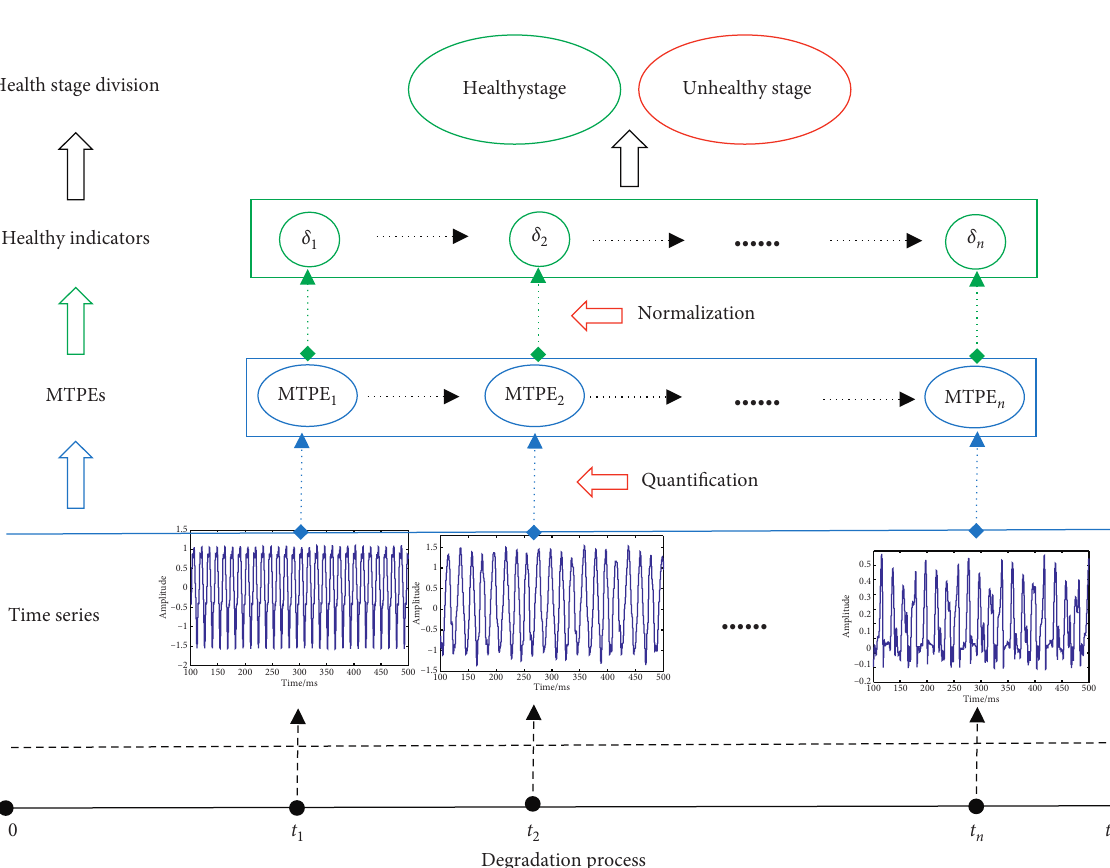
Figure 6: Procedures for performance degradation